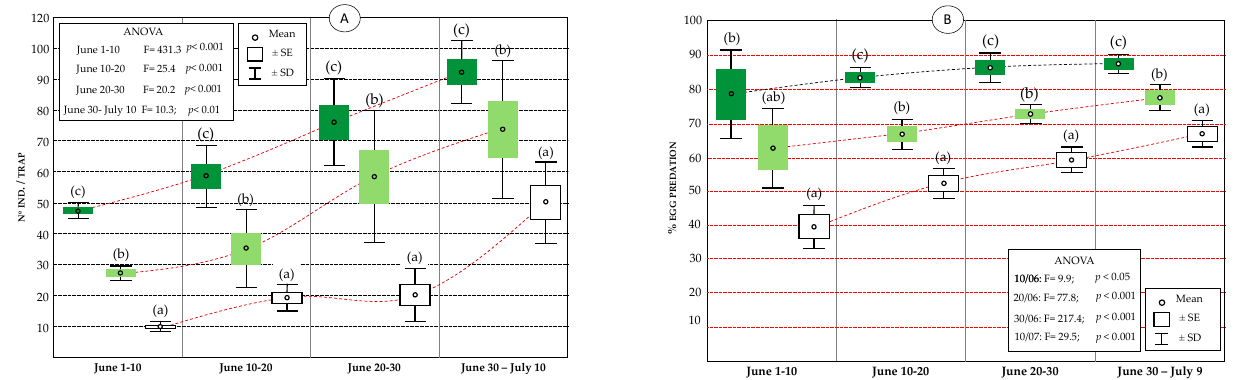
Figure 7. Statistics (mean, standard error, and standard deviation) of the catch values of lacewings in McPhail traps ( A ), and evolution of predation percentage ( B ) in the olive groves subject to different management: VC-MIX (dark green), VC (light green), and conventional (white). Significant differences within each sampling interval are indicated by letters (Tukey’s HSD test, p < 0.05).